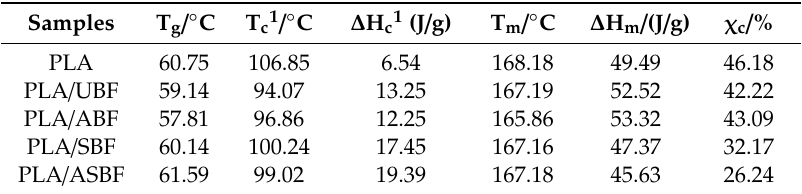
Figure 8. DSC curves of PLA/BF composites with different modified BF. Table 5. Thermal properties of PLA/BF composites with different modified BF.